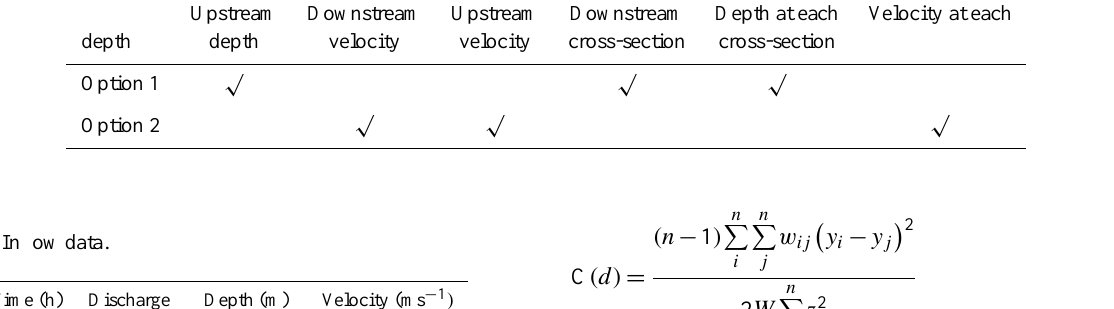
Table 1. Boundary condition requirements for the 1-D river model. (Option 2 is used in this study). Upstream Downstream Upstream Downstream Depth at each Velocity at each depth depth velocity velocity cross-section cross-section √ √ √ Option 1 √ √ √ Option 2